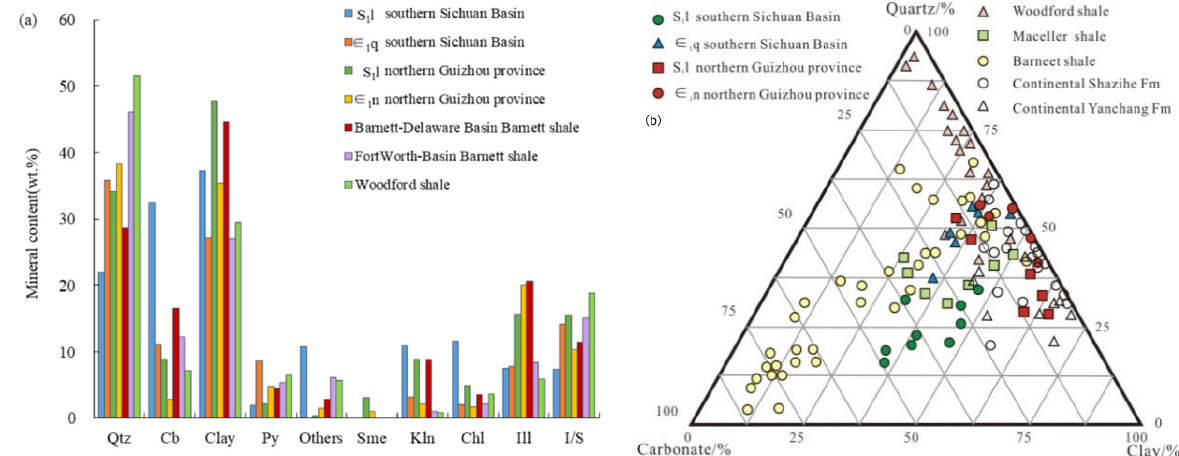
Figure 3. Mineral content cylindrical ( a ) and triangular ( b ) graphs of the Lower Paleozoic shale from the upper Yangtze plate. (S 1 1 = the Lower Silurian Longmaxi Fm, ∈ 1 q = the Lower Cambrian Qiongzhusi Fm, ∈ 1 n = the Lower Cambrian Niutitang Fm, Qtz = quartz, Cb = Carbonate mineral, Clay = Clay mineral, Dol = dolomite, Py = pyrite, Sme = smectite, Kln = kaolinite, Chl = chlorite, Ill = illite, I/S = illite/smectite).